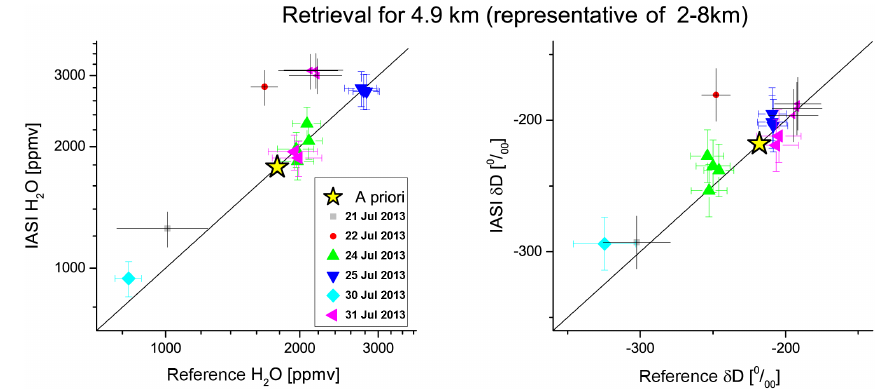
Figure 4. Same as Fig. 3 but for the correlation between reference data (in situ data measured by the ISOWAT instrument for 0–7km and climatology above, then smoothed with IASI kernels) and IASI data for 5km altitude. The colour code is for the different days. The data points for non-optimal coincidences as discussed in Appendix C can be identified by the smaller symbols and the black error